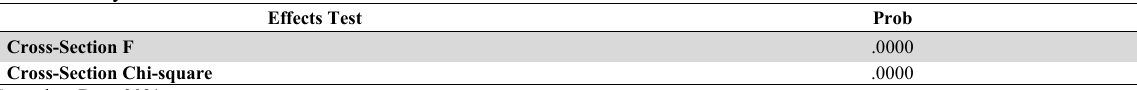
The summary of Chow test